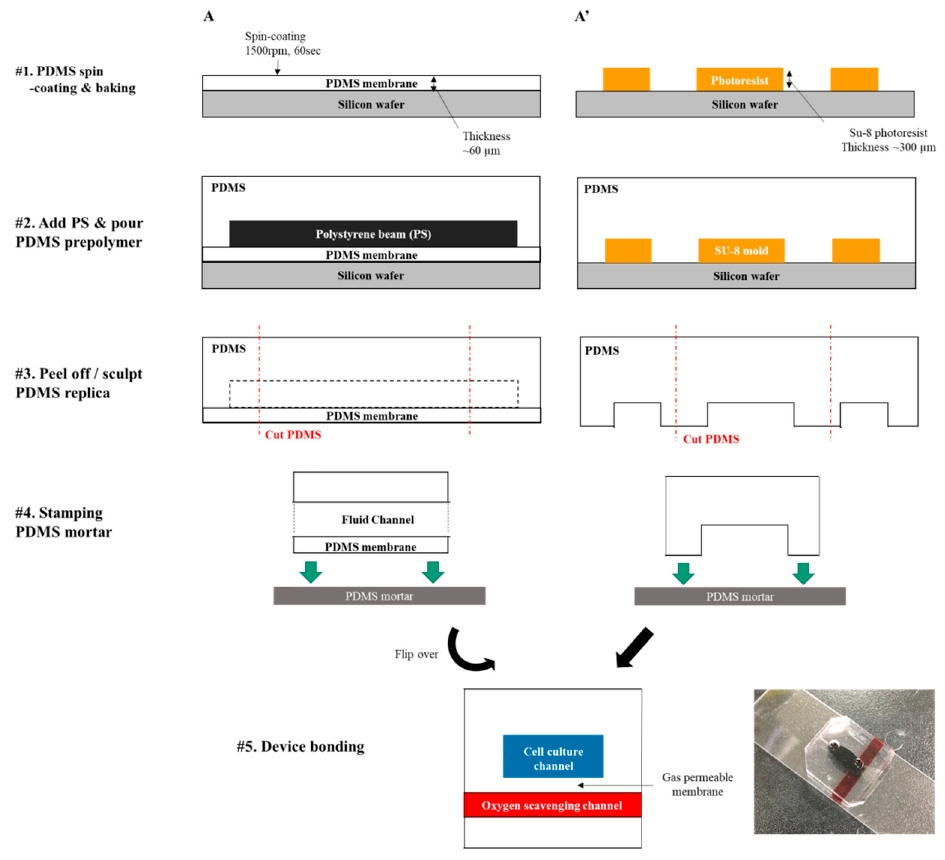
Figure 2. Fabrication steps of the microfluidic device using soft lithography.